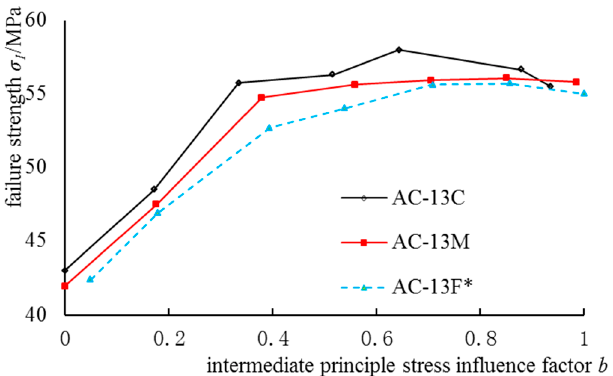
Figure 5. Intermediate principle stress influence factor b vs. strength of different gradation AC-13 mixture.